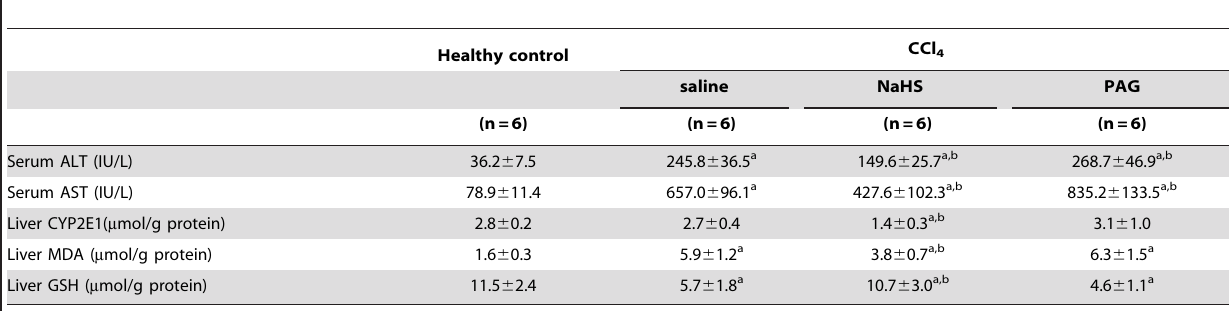
Table 1. Serum ALT and AST, and hepatic CYP2E1, MDA and GSH in hepatotoxicity